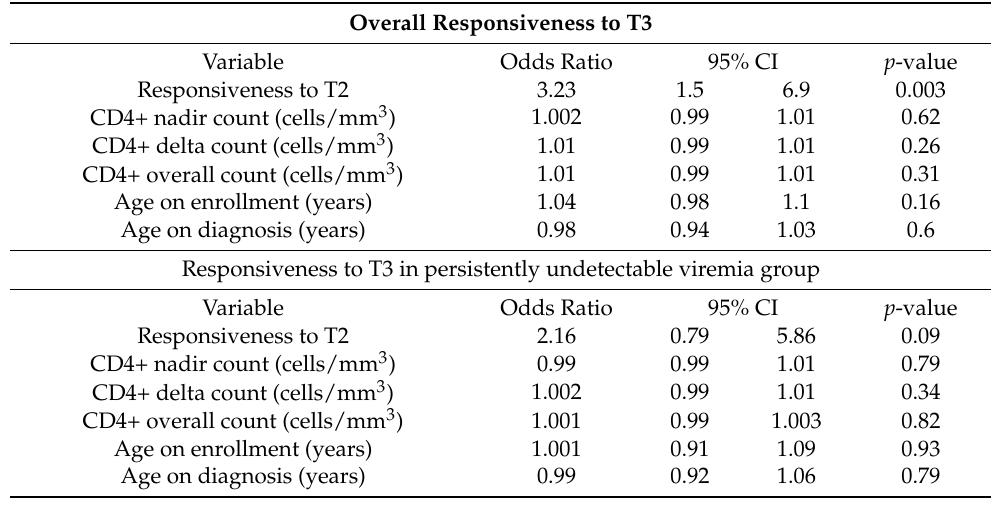
Table 5. Logistic analysis of responsiveness to T3, overall and by viremic group. In bold: results with statistical significance level p <